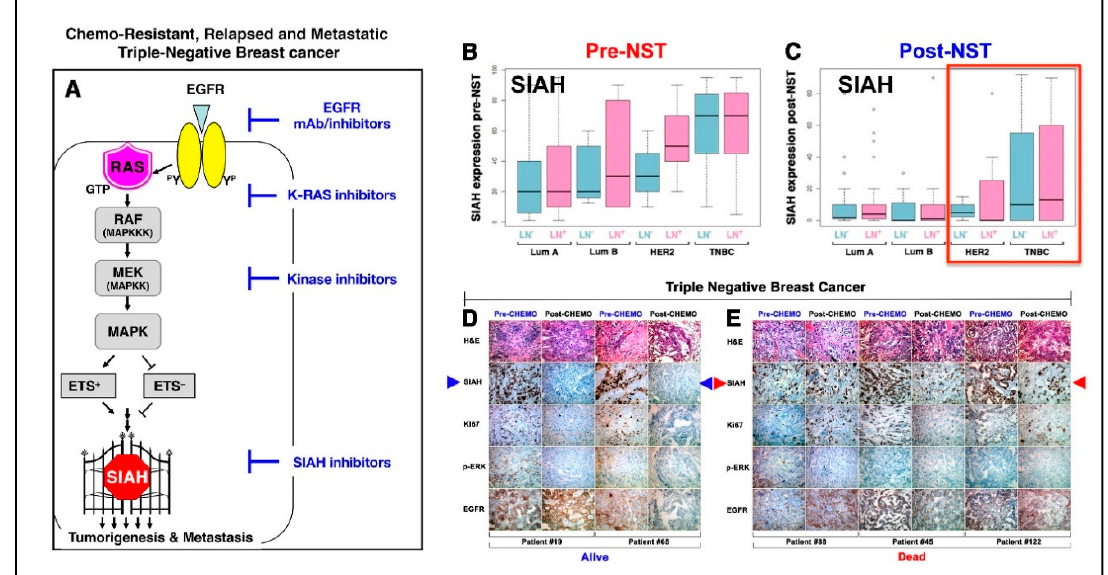
Figure 1. SIAH ON/OFF binary expression in residual tumors post-neoadjuvant systemic therapy (NST) can be used to risk-stratify pIR patients and predict patient survival in high-risk TNBC at 5 years. ( A ) Schematic illustration of the K-RAS–SIAH–EGFR pathway activation in TNBC. SIAH is the most downstream “gatekeeper” signaling module in the canonical K-RAS/EGFR signal transduction pathway in TNBC. ( B , C ) Loss of SIAH expression is correlated with K-RAS pathway inactivation and tumor regression, whereas persistent SIAH expression is correlated with K-RAS activation and tumor relapse in breast cancer of mixed molecular subtypes. The box-and-whisker plots were used to graphically illustrate the population distribution of median SIAH expression levels in both node-positive (as marked by purple color bar graphs) and node-negative (as marked by teal color bar graphs) in breast cancer of the four molecular subtypes: Luminal A (LumA), Luminal B (LumB), HER2, and TNBC. ( B ) The median SIAH expression levels in the untreated node-negative and node-positive primary tumors of the 4 molecular subtypes pre-NST are shown: Luminal A (LN-negative LumA at 20% and LN-positive LumA at 20%), Luminal B (LN-negative LumB at 20% and LN-positive LumB at 30%), HER2-positive breast cancer (LN-negative HER2-positive breast cancer at 30% and LN-negative HER2-positive breast cancer at 50%), and TNBC (LN-negative TNBC at 70% and LN-positive TNBC at 70%). The data showed that TNBC has the highest proliferative index in a peerwise comparison. ( C ) The median SIAH expression levels in the treated node-negative and node-positive residual tumors of the 4 molecular subtypes post-NST are shown: Luminal A (LN-negative LumA at 2% and LN-positive LumA at 3%), Luminal B (LN-negative LumB at 0.5% and LN-positive LumB at 1%), HER2-positive breast cancer (LN-negative HER2-positive breast cancer at 3% and LN-negative HER2-positive breast cancer at 0.5%), and TNBC (LN-negative TNBC at 8% and LN-positive TNBC at 15%). The data showed that TNBC is a high-risk cohort with intrinsic chemo-resistance, independent of the LN status, in a group comparison. The error bars or whiskers in the histogram and bar charts represent the 95% CI, and in the box plots, they represent the upper (top) and lower quartiles (bottom) data distribution—with points beyond 95% CI representing the outliers. Importantly, SIAH ON expression can be used to accurately identify the individual pIR outliers with high SIAH expression and poor survival in breast cancer. ( D , E ) Representative IHC images of SIAH, EGFR, phospho-ERK, and Ki67 staining in TNBC pIR residual tumors are shown. ( D ) The pIR patients with no or low SIAH expression in residual tumors post-NACT stayed in remission. SIAH OFF marked chemo-sensitive TNBC tumor cells that have stopped growing post-NACT, predicting increased patient survival ( Alive ). ( E ) The partial responders with high SIAH expression in residual tumors (despite 90% tumor shrinkage) post-NACT developed tumor relapse and succumbed to their metastatic diseases. SIAH ON identified chemo-resistant TNBC tumor cells that are still growing post-NACT, thus predicting poor survival ( Dead ). Conclusion : For TNBC pIR patients with 70–90% tumor reduction post-NACT, it is evident that persistent high SIAH expression in residual tumors will predict early tumor relapse, poor prognosis, and reduced survival, whereas no or low SIAH